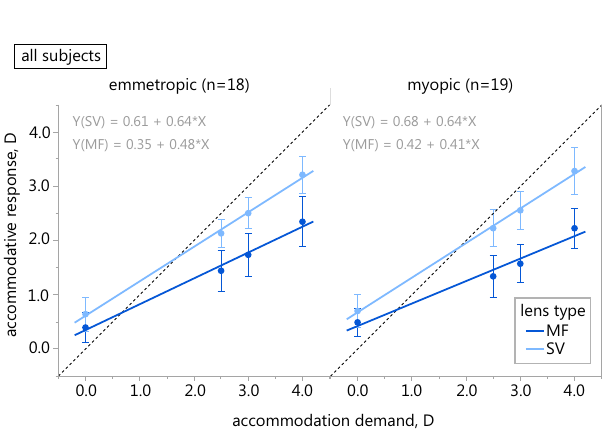
Figure 2. Stimulus-response function in different contact lens wear. Accommodation stimulus-response function of emmetropic (left) and myopic group (right) with single vision (light blue) and multifocal soft contact lenses (dark blue). Error bars denote SD of the mean; the dashed line has a slope of